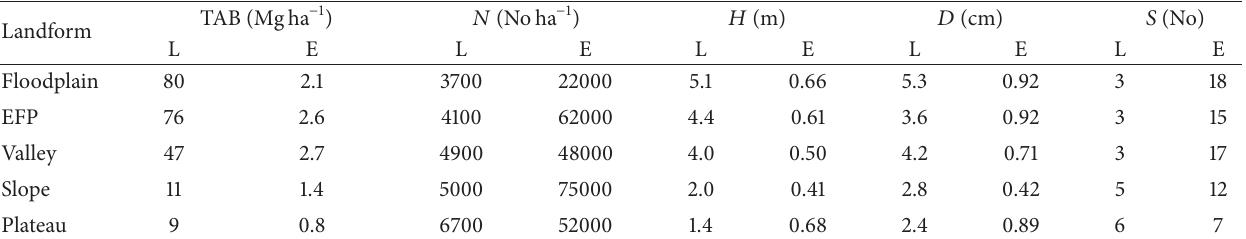
Table 2: The mean spatio-temporal variations of diversity and abundance of species along a productivity gradient in the Tamaulipan thornscrub of northeastern Mexico.